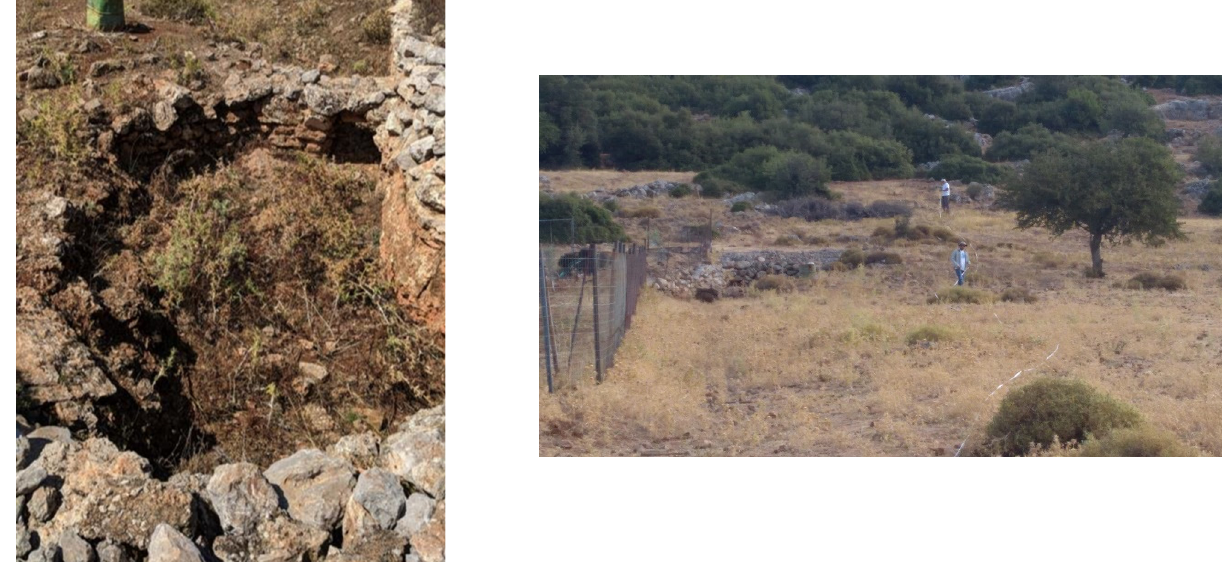
Figure 14. The cistern of the northern side sinkhole at Meteles, close up (left) and at a distance (right) (© IL).